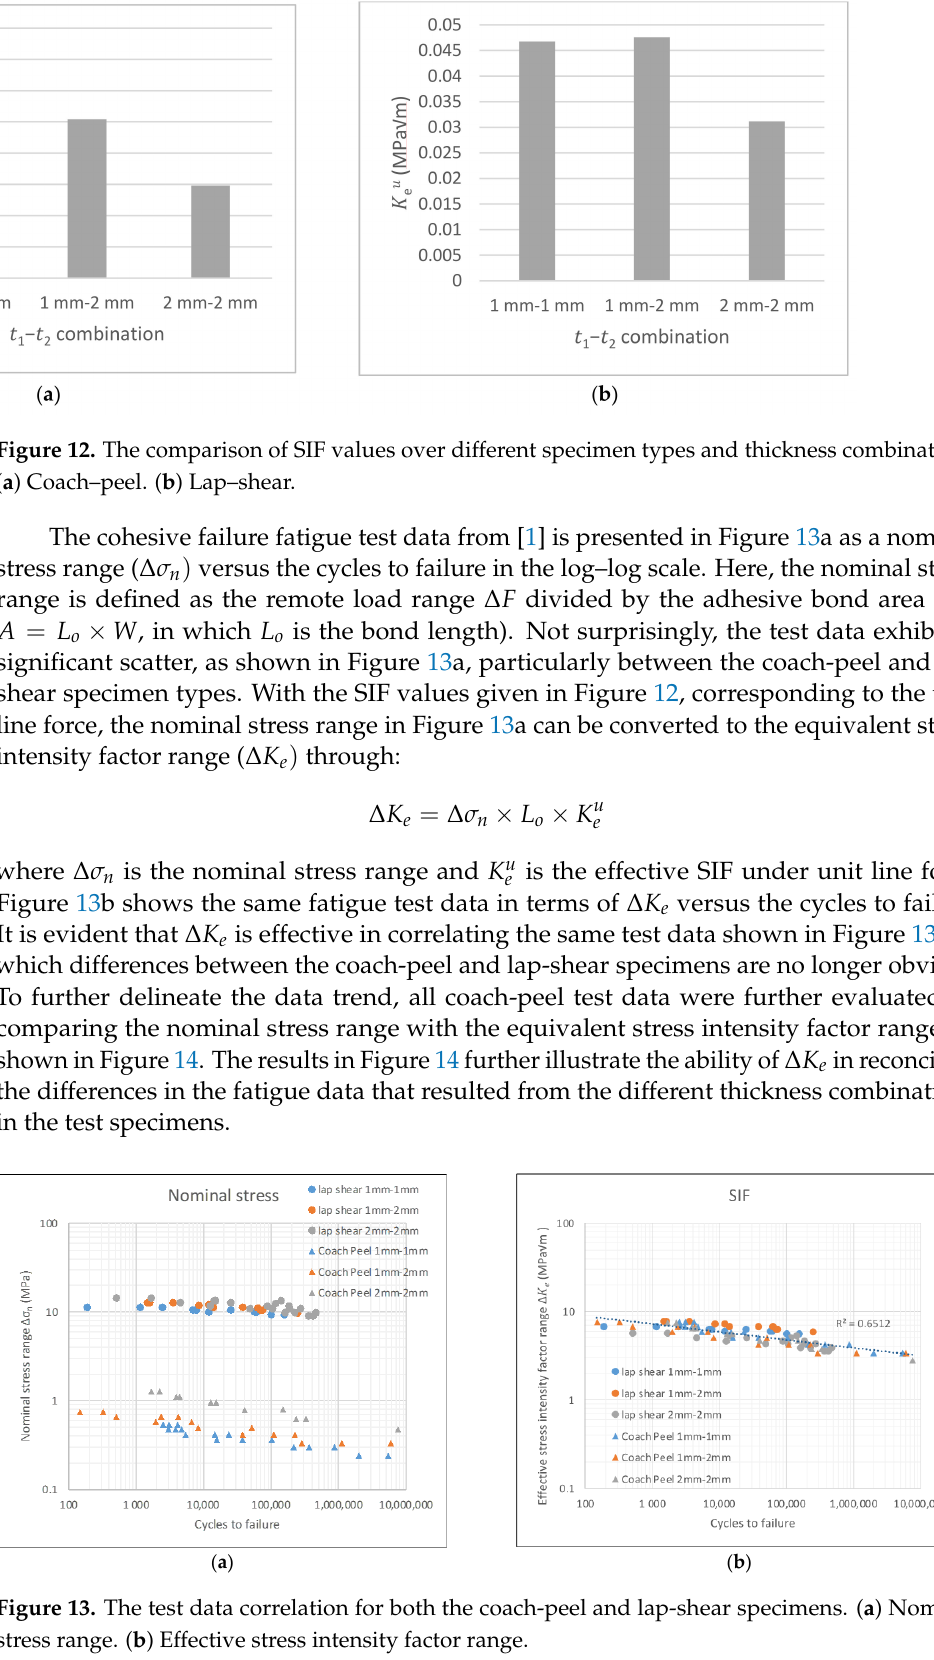
( b ) Figure 14. The test data correlation of the coach-peel test specimens. ( a ) Nominal stress range. ( b ) Effective stress intensity factor range. 4. Discussions 4.1. Existence of Critical Bond Length As discussed in Section 2.3, there exists a threshold or critical bond length ( 𝐿 𝑐 /𝑡) in terms of 𝐿/𝑡 beyond which the SIF values tend to become stabilized. This can have im- portant engineering implications in the optimum joint design to ensure that the adhesive bond length 𝐿 is somewhat larger than 𝐿 𝑐 , but not too large to incur manufacturing costs and adding weight. For illustration purposes, we can define the critical bond length 𝐿 𝑐 as the length within which 𝐾 ≥ 1.05𝐾 0 . Here, 𝐾 0 represents the stabilized value corre- sponding to the infinitely long bond line. Figures 15 and 16 show the results correspond- ing to Case 1 (see Section 2.2.1) subjected to the pure moment 𝑚 0 loading. In Figures 15a and 16a, the 𝑥 - and 𝑦 -axis definitions were the same as in Figure 7a. Figures 15b and 16b demonstrate how the non-dimensional critical bond length 𝐿 𝑐 /𝑡 is influenced by the non- dimensional thickness ratio 𝑡/𝑡 𝑎 or non- dimensional Young’s modulus ratio 𝐸/𝐸 𝑎 . The reference solution corresponds to the sandwich geometry and property combinations as- sociated with the test specimens used in [1], as summarized in Section 3.1. As shown in